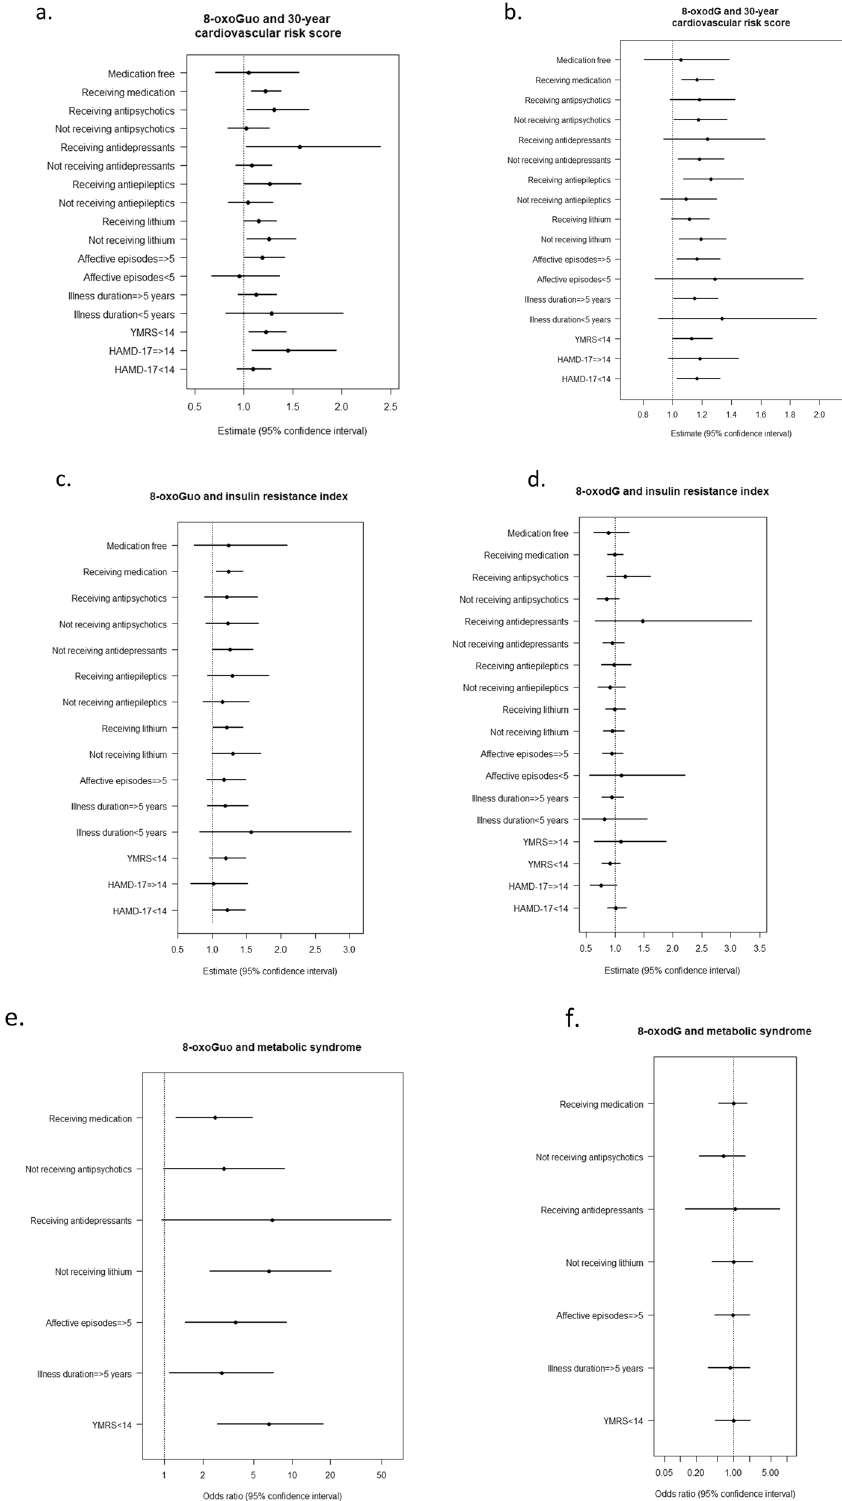
Fig. 3 Associations between cardiovascular disease risk measurements and oxidative stress within patients newly diagnosed with bipolar disorder. Forest plots exploring the effects of illness- and medication variables on the associations between 30-year cardiovascular risk score and levels of 8-oxoGuo ( a ) and 8-oxodG ( b ), insulin resistance and levels of 8-oxoGuo ( c ) and 8-oxodG ( d ) and metabolic syndrome and levels of 8-oxoGuo ( e ) and 8-oxodg8-oxodG ( f ) in patients newly diagnosed with bipolar disorder. Analyses were run as separate multiple linear regression analyses adjusted for sex and